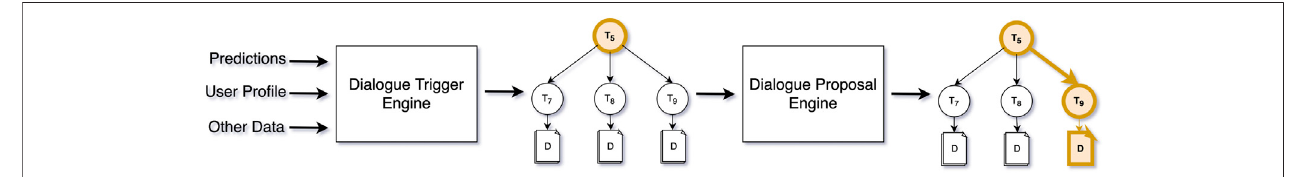
FIGURE 6 | The fl ow for triggering and suggesting dialogues, from derived real-world data, to trigger, to dialogue